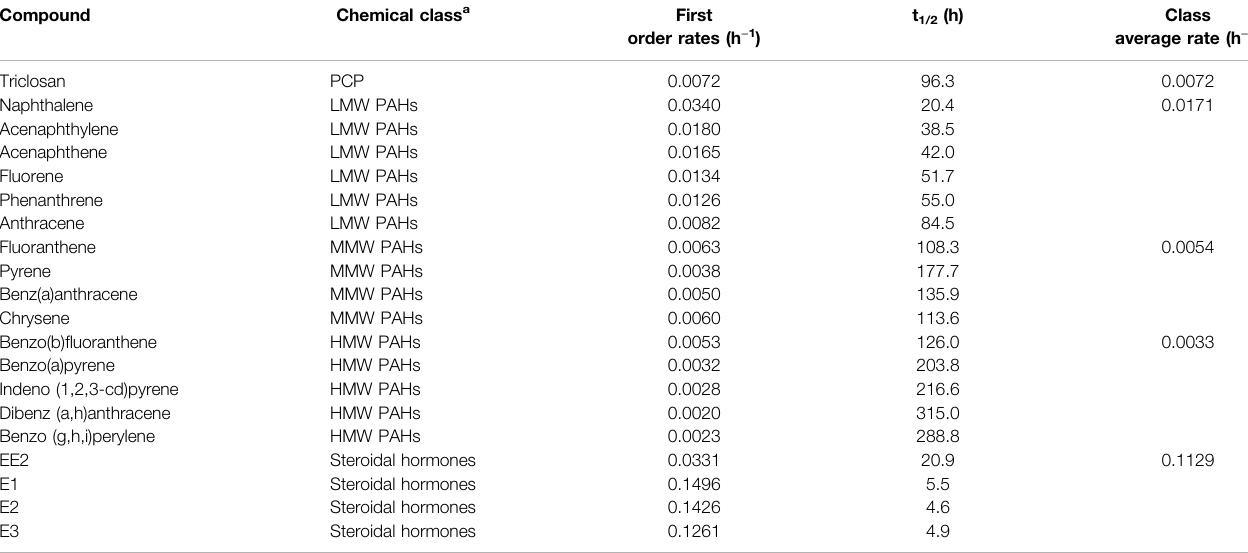
TABLE 1 | Degradation rates of different classes of chemicals under aerobic conditions with activated sludge inocula. Compound Chemical class